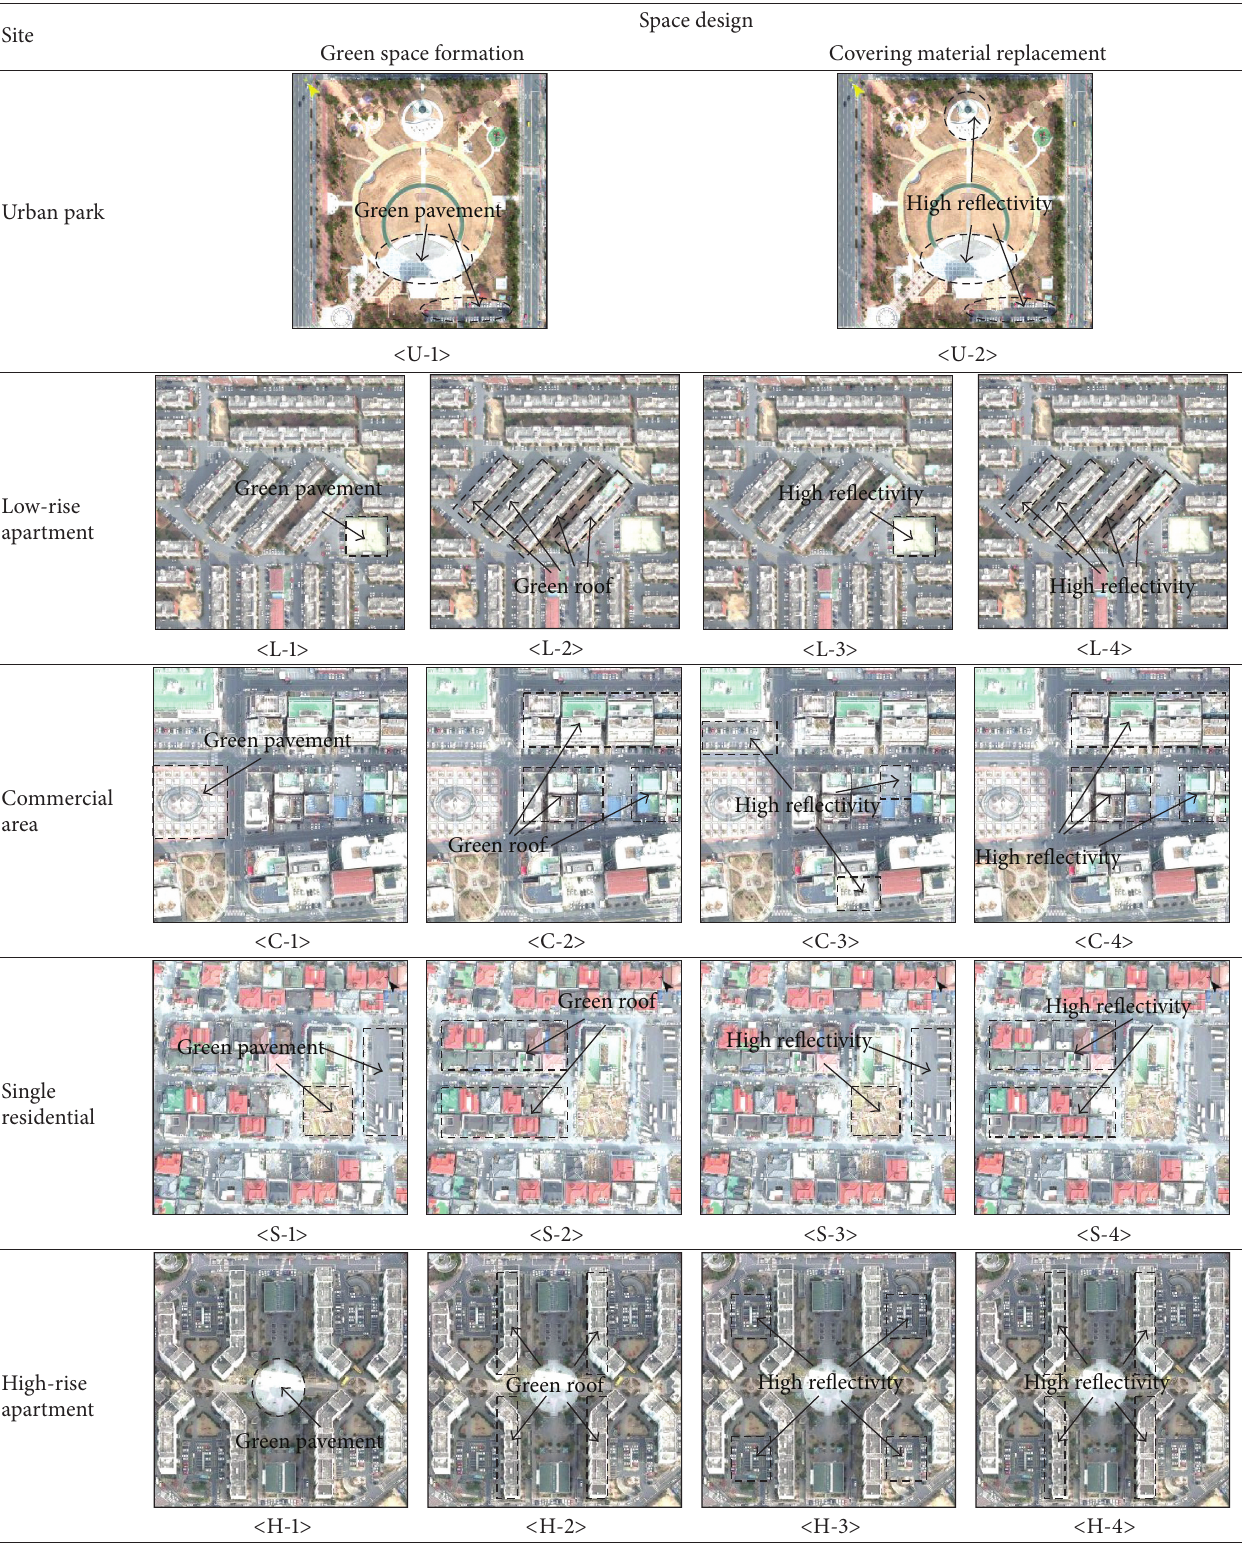
Table 3: Space design plan for each target